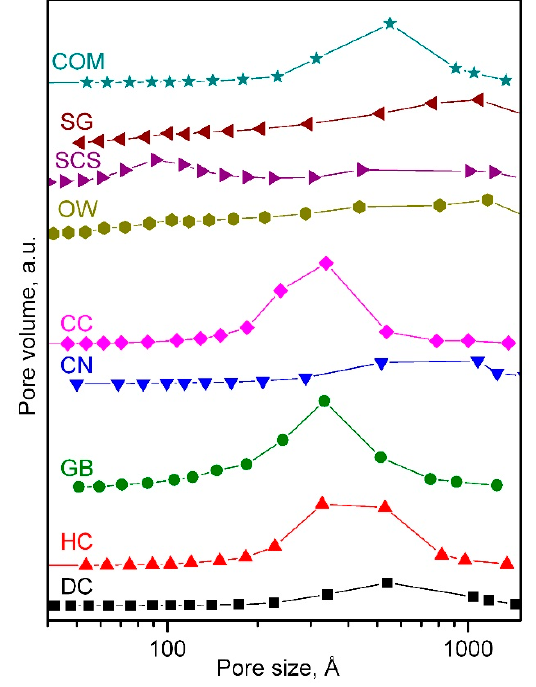
Figure 1. Pore size distributions of the bulk Co 3 O 4 catalysts.